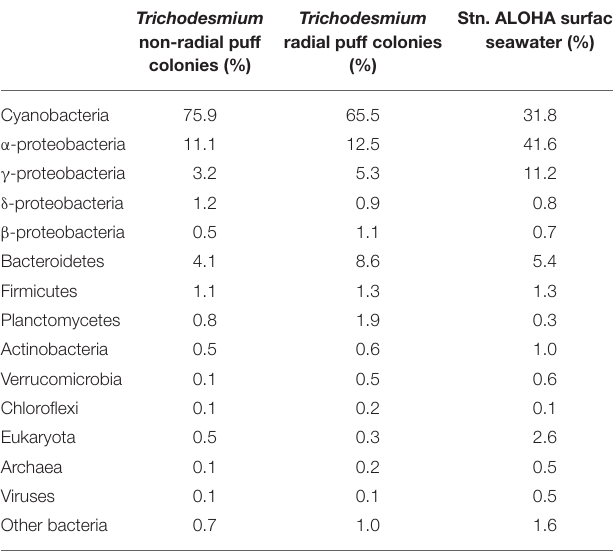
TABLE 4 | Taxonomic assignments from three metagenome